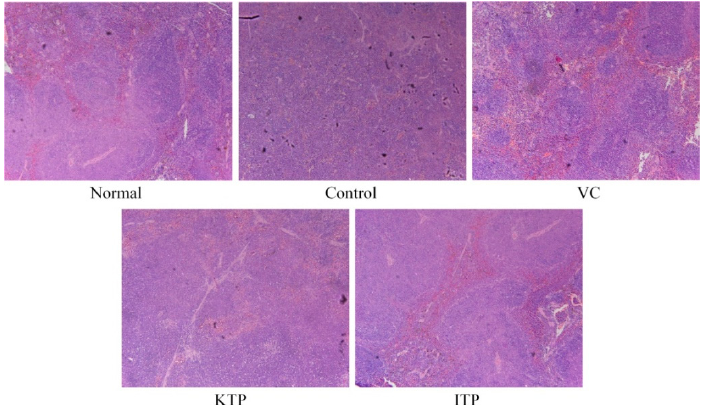
Figure 3. H&E pathological observation of spleen in mice. Magnification 100×. VC: vitamin C (200 mg/kg body weight); KTP: Kuding tea polyphenols (200 mg/kg body weight); ITP: insect tea polyphenols (200 mg/kg body weight).